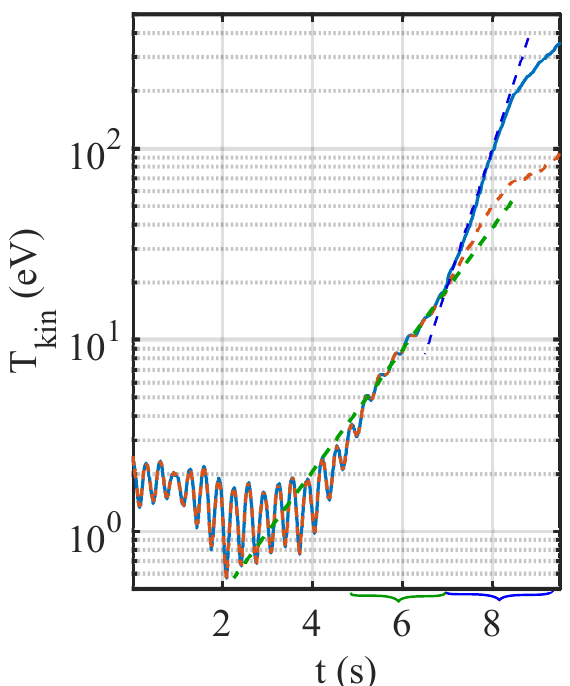
Figure 5. Evolution of the microparticle kinetic temperature T kin using the two different linking ( t ) as starting point (quasi-static approximation). strategies: Dashed orange curve: Using R i N + 1 MP ( t ) as starting point (position prediction). The dashed green and blue Plain blue curve: R i N + 1 Pred lines represent the energy growth during the crystalline mode coupling instability (MCI) and fluid MCI, respectively. The green and blue curly brackets show the periods of time corresponding to the crystalline MCI and fluid MCI, respectively. Note the difference in energy growth during fluid MCI when using the different linking